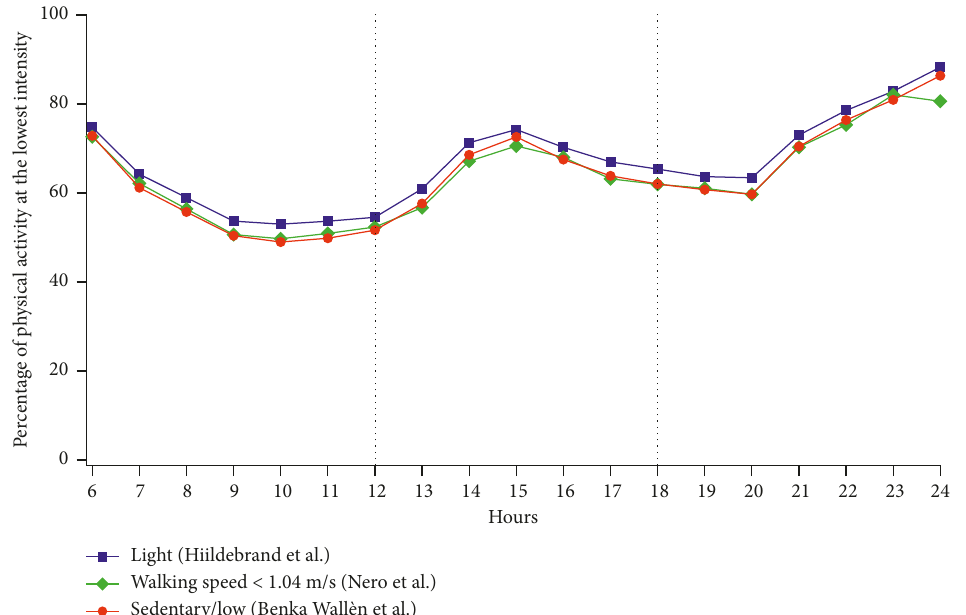
Figure 3: Hourly trends for lowest-intensity physical activity (